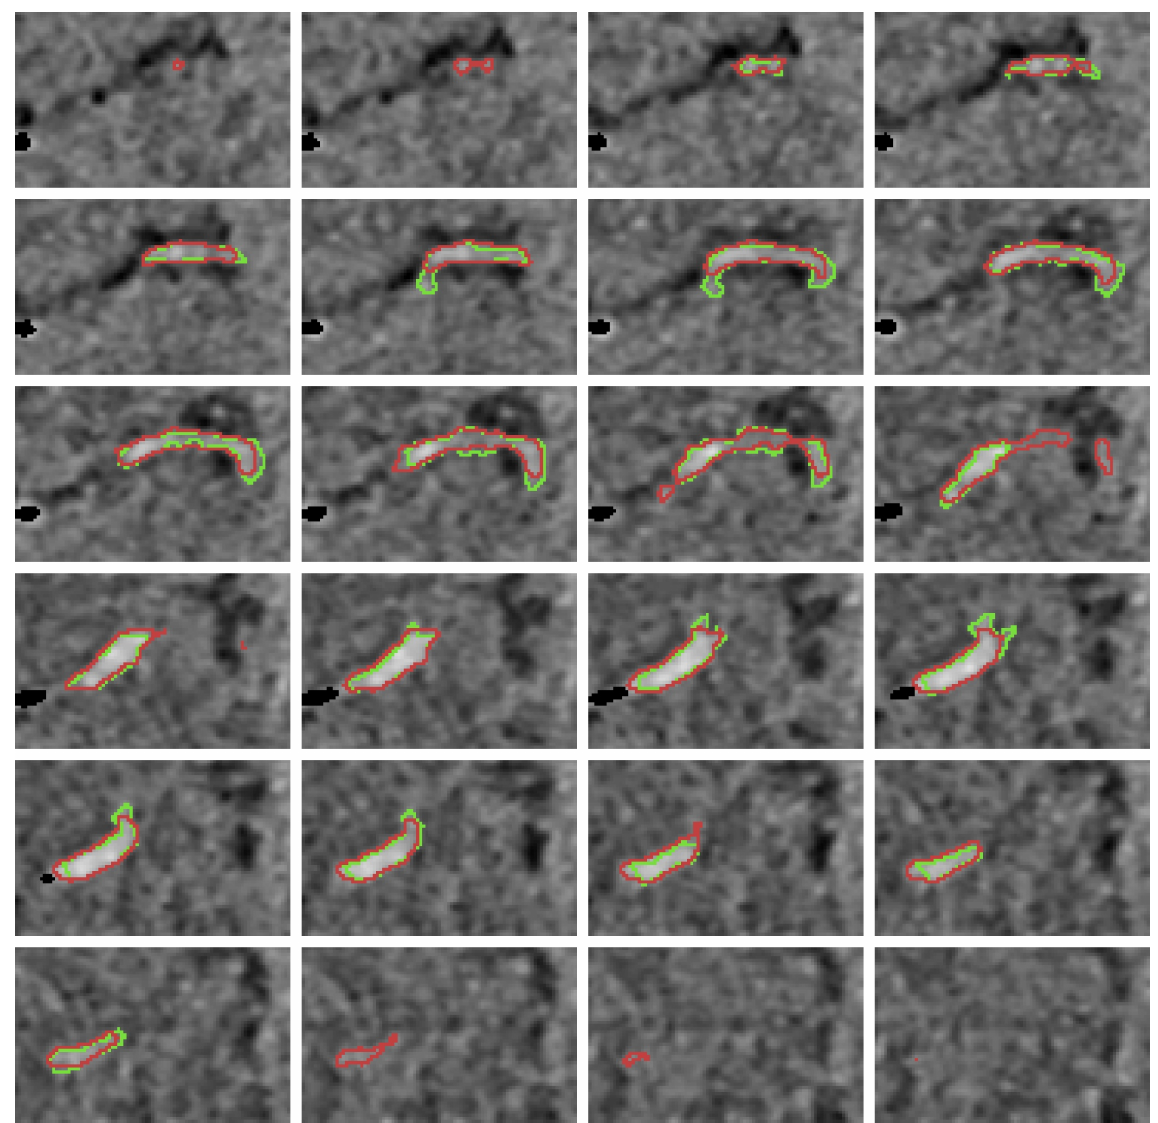
Figure A2. Slice-by-slice presentation of segmentation prediction and ground truth on NCCT in a bounding box for one patient. Surface Dice of this prediction is 0.98 and Dice is 0.81. The contours of the ground truth annotation and segmentation prediction are shown in green and red,